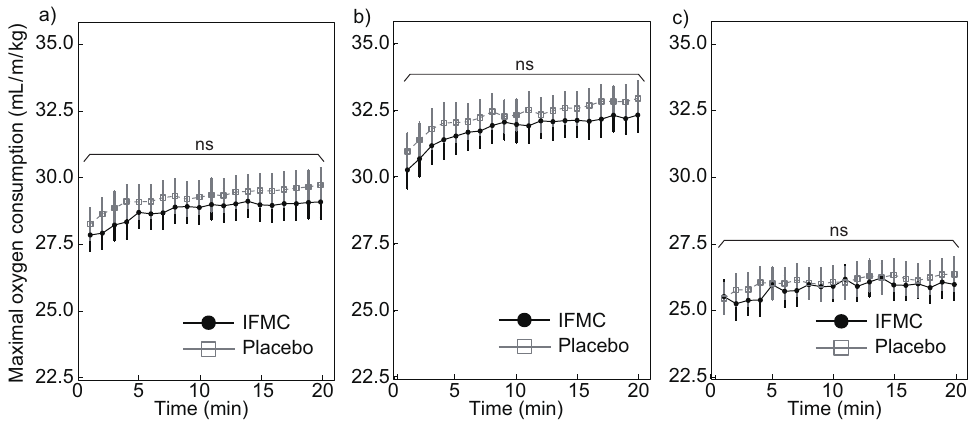
Figure 5. Differences in ( a ) all, ( b ) male, and ( c ) female maximal oxygen consumption over 20 min between IFMC and placebo applications. The “ns” stands for “not significant ( p > 0.05)”.